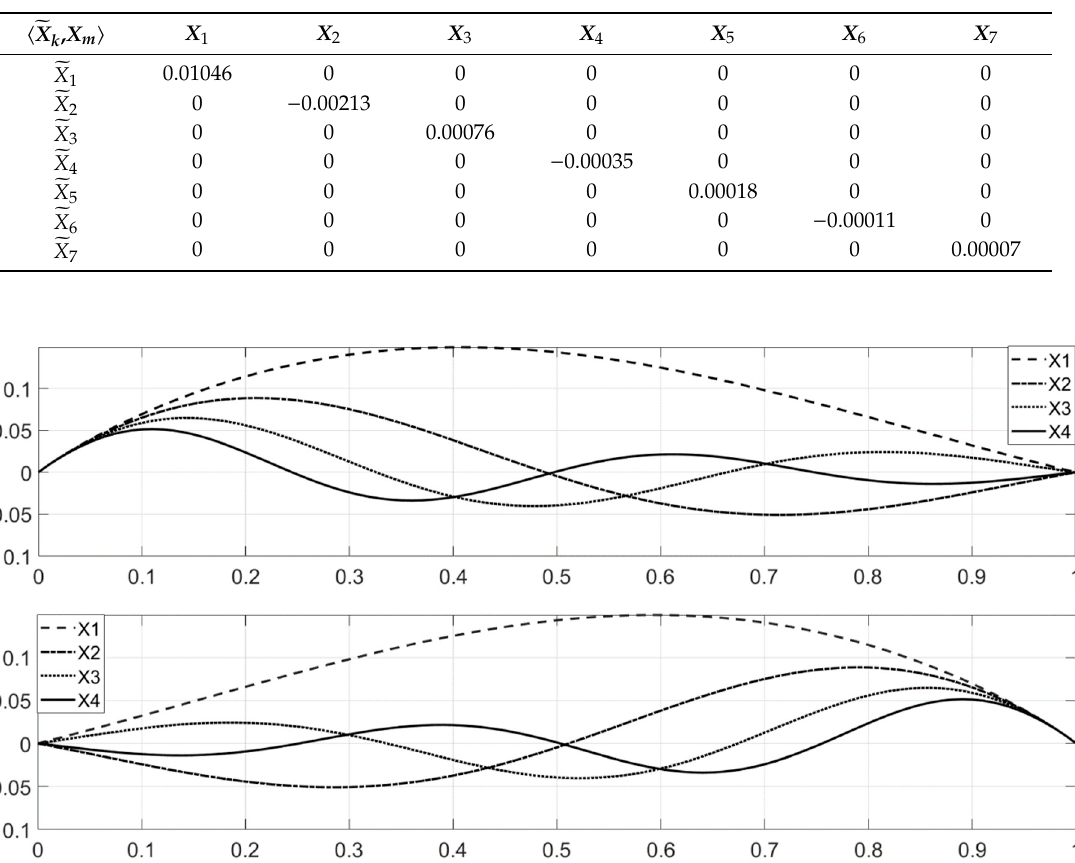
(cid:111) (cid:110) (cid:8) (cid:9) (cid:101) X m ( x ) X m ( x ) (at the m = 1;2; ... , (at the top) and m = 1;2; ...